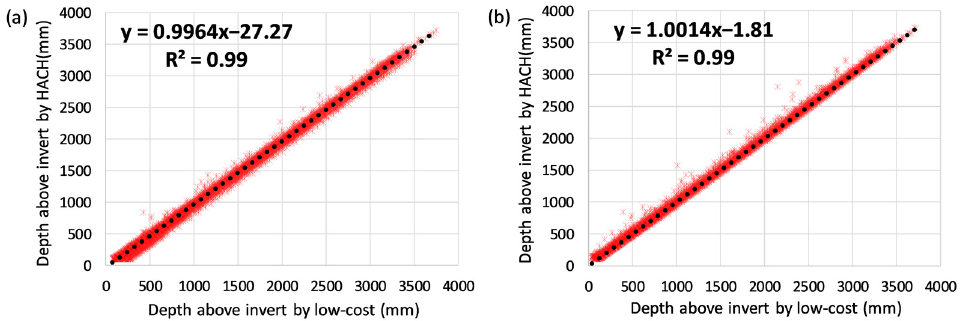
Figure 6. Comparing the depth of water above the drain’s invert from the low-cost depth sensor and the HACH submerged probe: ( a ) raw low-cost sensor readings without conduction continuous automatic re-calibration; ( b ) low-cost sensor conducting re-calibration when HACH reached its lowest detection limit—9 mm.